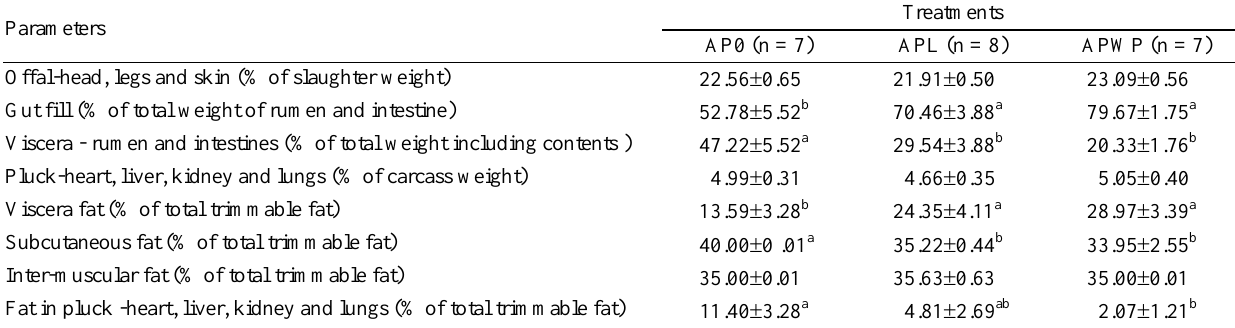
Table 4. Composition of non-carcass components of goats fed diets containing Andrographis paniculata Parameters